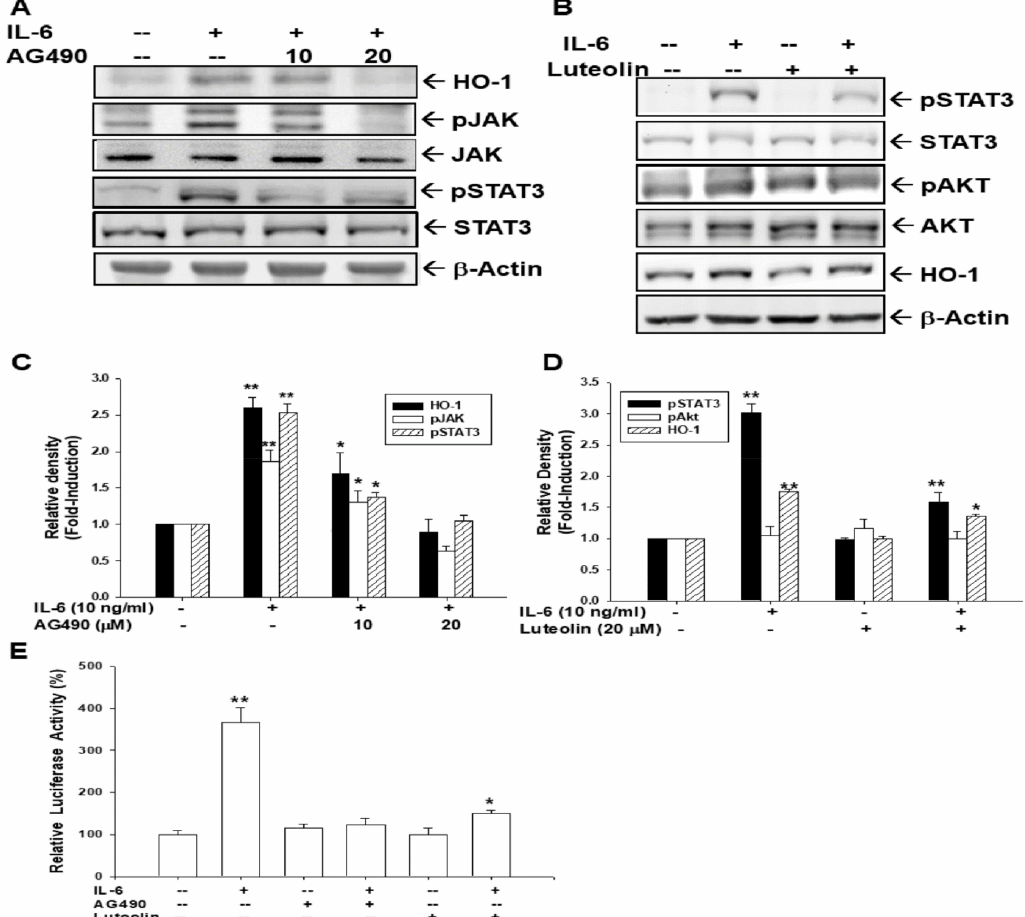
Figure 7. AG490 and luteolin block the activation of Interleukin-6 in heme oxygenase-1 expression throughthedownregulationof STAT3phosphorylation. ( A )HepG2 cellswereco-treatedbyrecombinant human IL-6 (10 ng / mL) and various doses of AG490, as indicated, for 16 h. The expression of HO-1, STAT3, and phospho-STAT3, JAK, phospho-JAK, and β -Actin were determined by immunoblot assays. ( B ) HepG2 cells were co-treated with recombinant human IL-6 (10 ng / mL) with or without luteolin (20 µ M) for 16 h. Protein levels of HO-1, STAT3, phospho-STAT3, AKT, phospho-AKT, or β -Actin were analyzed using immunoblot assays. The quantitative data of IL-6 and / or AG490 ( C ) and IL-6 and / or luteolin ( D ) treatments were expressed as the intensity of the protein band of the target gene / β -actin or phosphorylation protein / total protein relative to the control solvent-treated group ( n = 3). ( E ) The HO-1 reporter vector (pHO1-KX) of transfected HepG2 cells was treated with IL-6 (10 ng / mL), AG490 (20 µ M), and / or luteolin (20 µ M) for 16 h. Data are expressed as mean percent ± SE ( n = 6) of luciferase activity relative to the solvent-treated group. (*, p < 0.05; **, p <